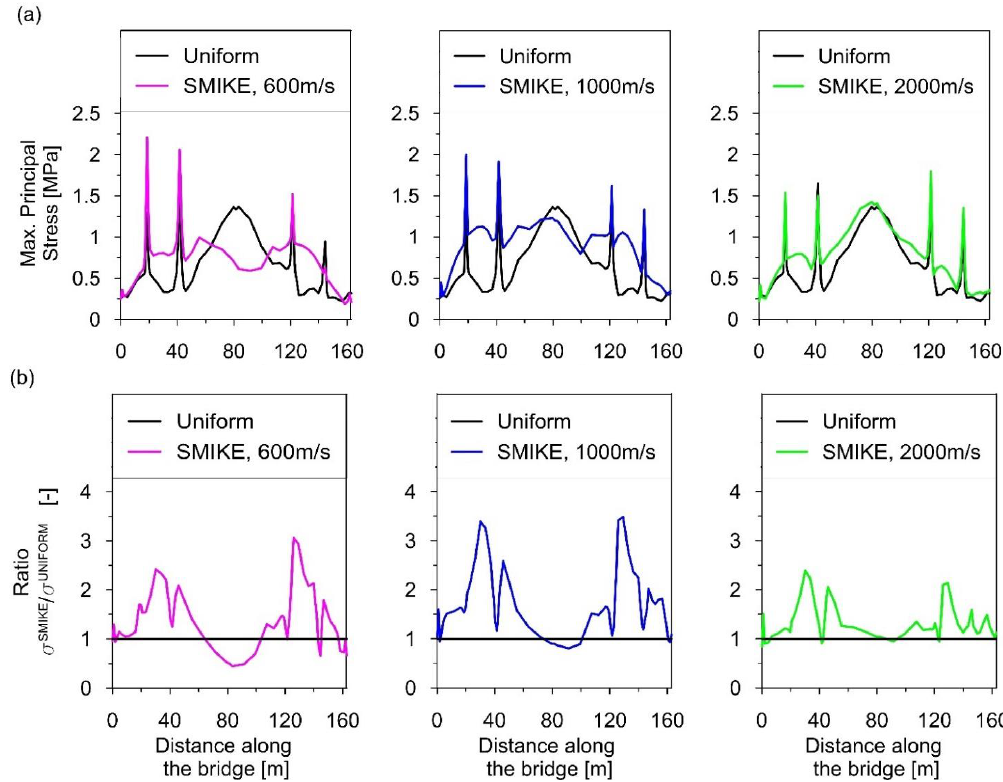
Figure 19. The SMIKE Model vs. the Uniform Model of Excitation: ( a ) comparison of the maximal principal stress envelopes, ( b ) the stress envelope ratio: SMIKE model to uniform model.